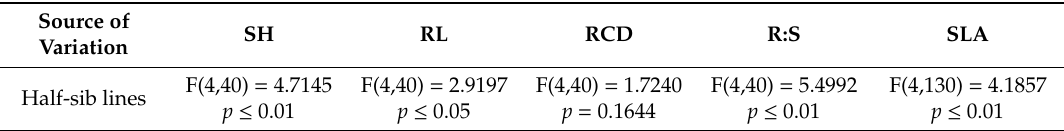
Table 2. Results of the analysis of variance for measured biometrical parameters of the studied Quercus robur half-sib